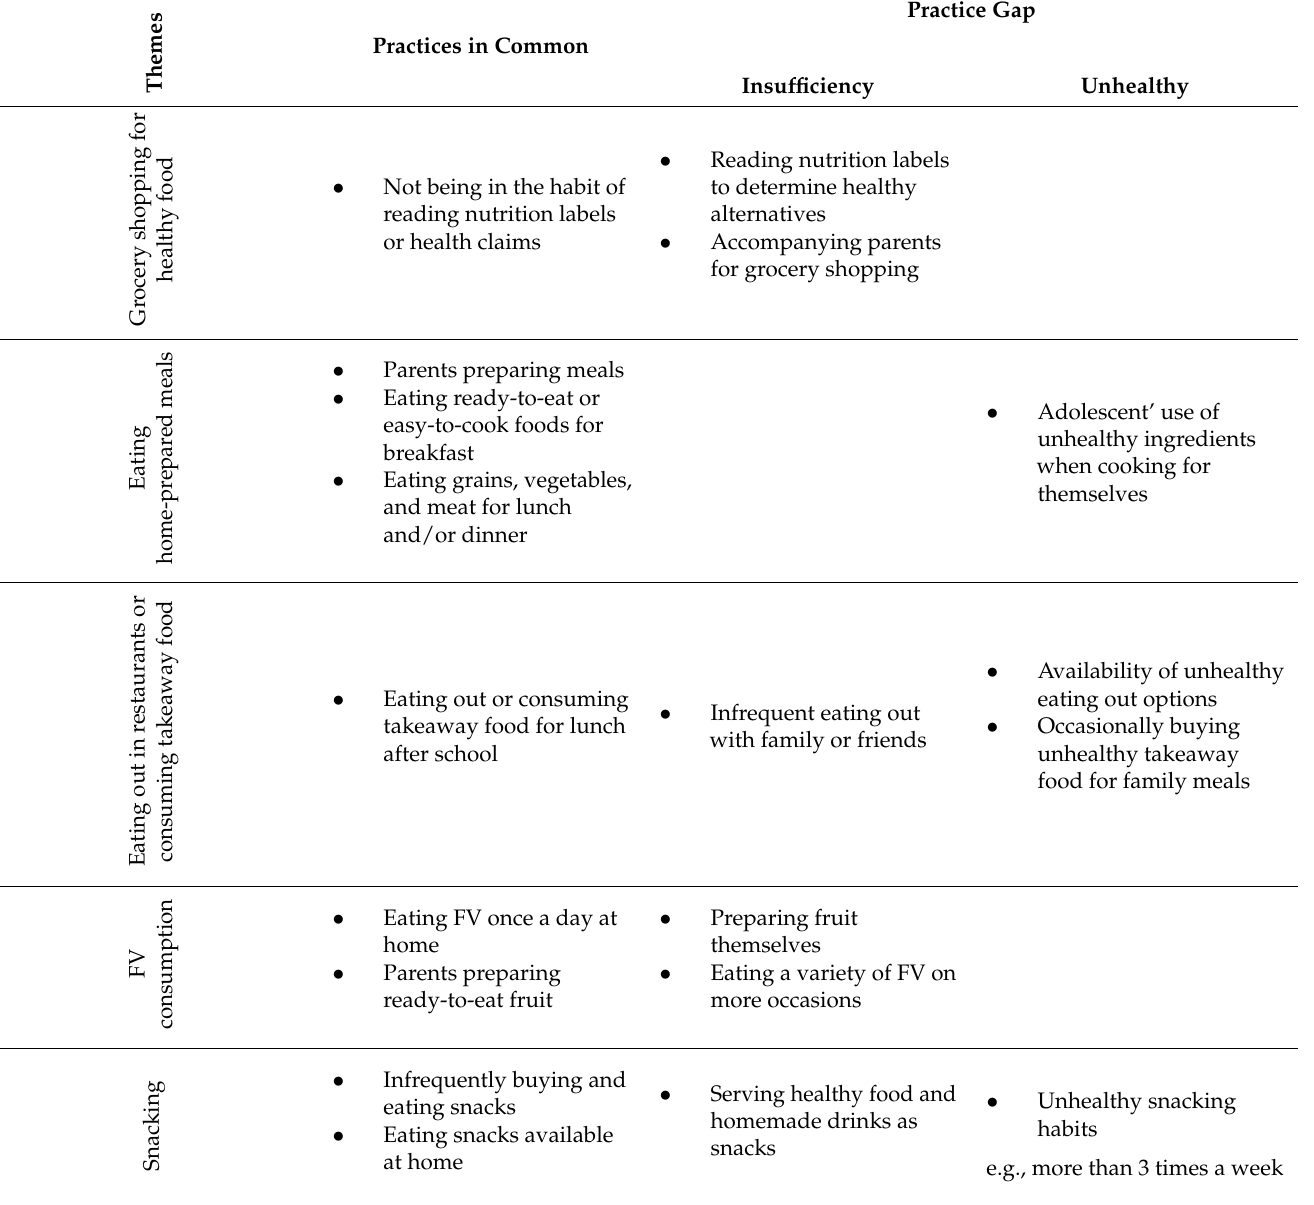
Table 5. Summary of themes on adolescent practices of healthy